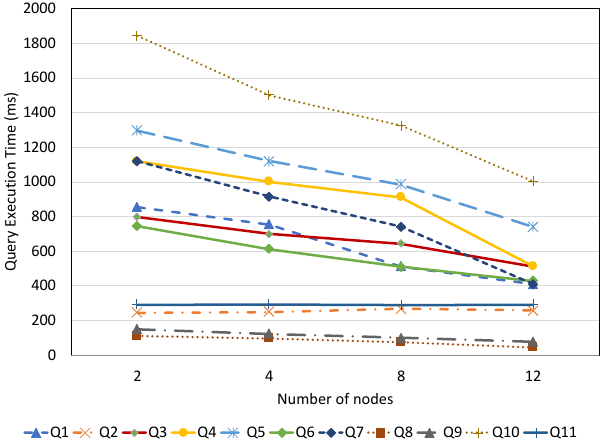
Figure 26. Average query execution time by varying number of cluster